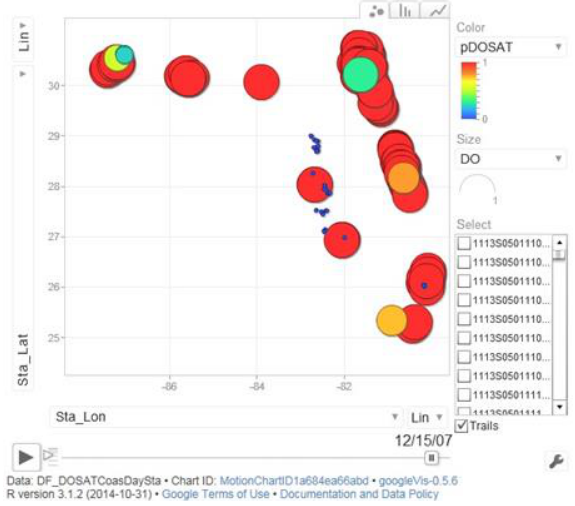
Figure 1 . Coastal DO and pDOSAT motion chart.